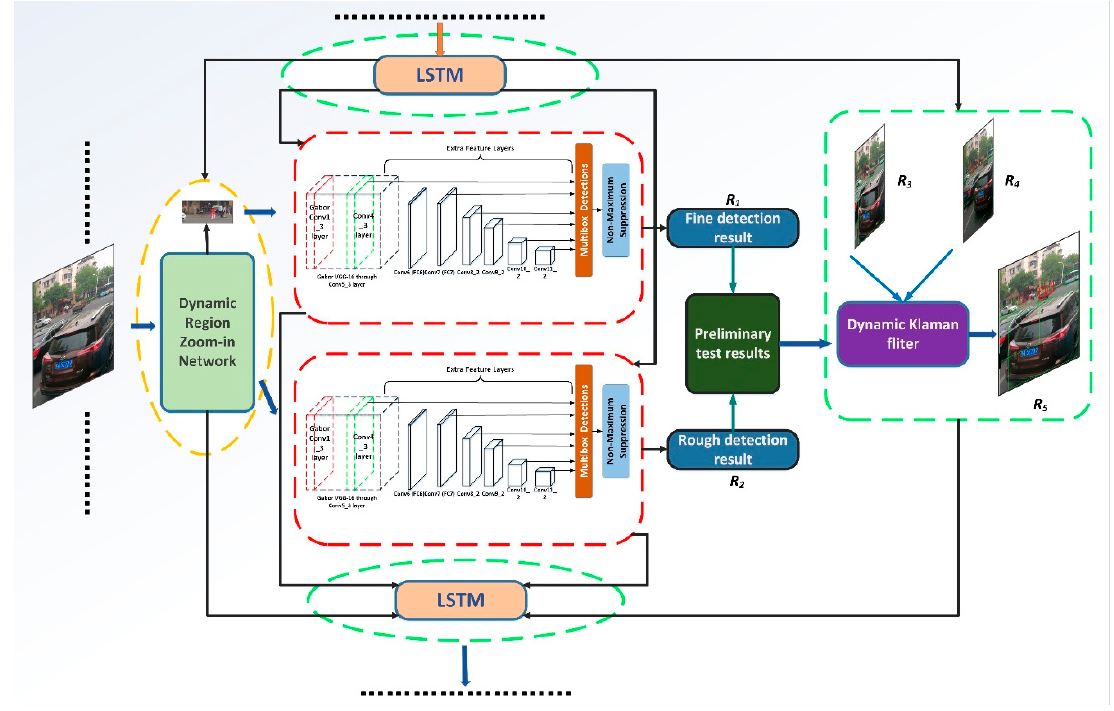
Figure 11. Overall framework of the improved detection algorithm.